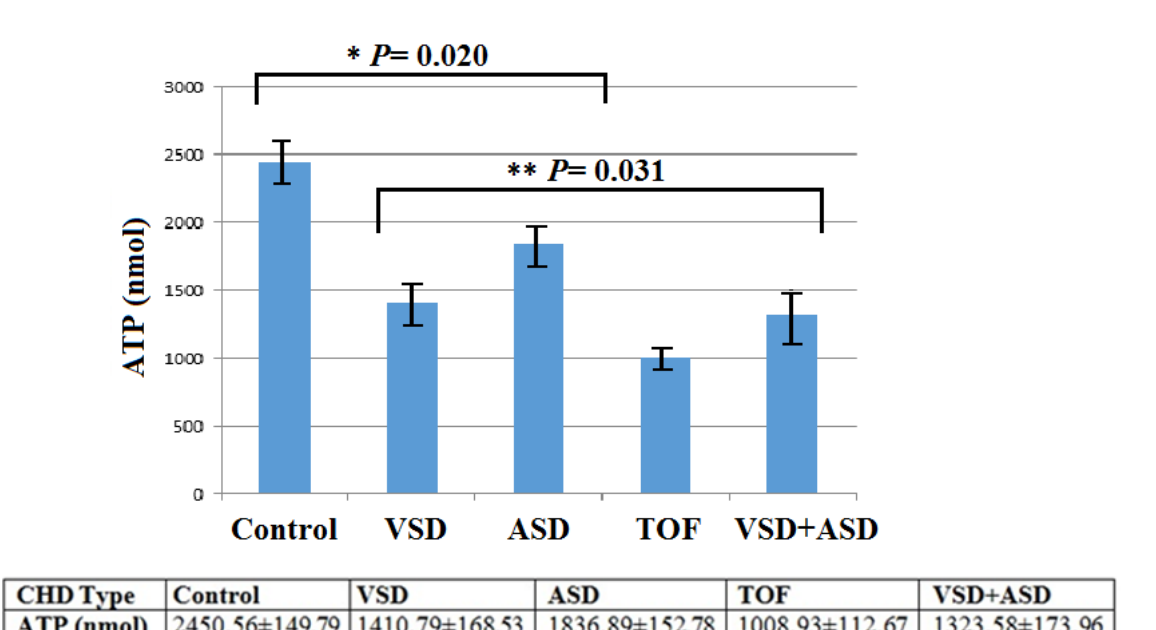
Figure 6: Bar diagram showing the intracellular ATP content in lymphocytes from healthy control and CHD patients (VSD, ASDS, TOF, and VSD+ASD). Intracellular ATP (nmol) was significantly reduced in patients with various type of CHD compared to the control group (*: significance line between patients and control group: P = 0.020 and **: significance line between CHD patients: P =